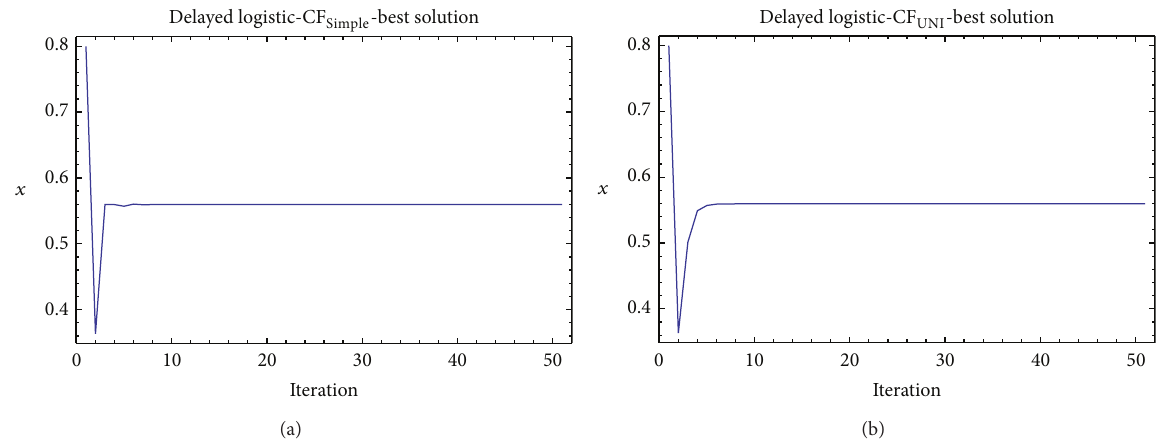
Figure 13: Simulation of the best individual solution, ChaosDE and delayed logistic: case study 3, CF Simple (a); case study 4, CF